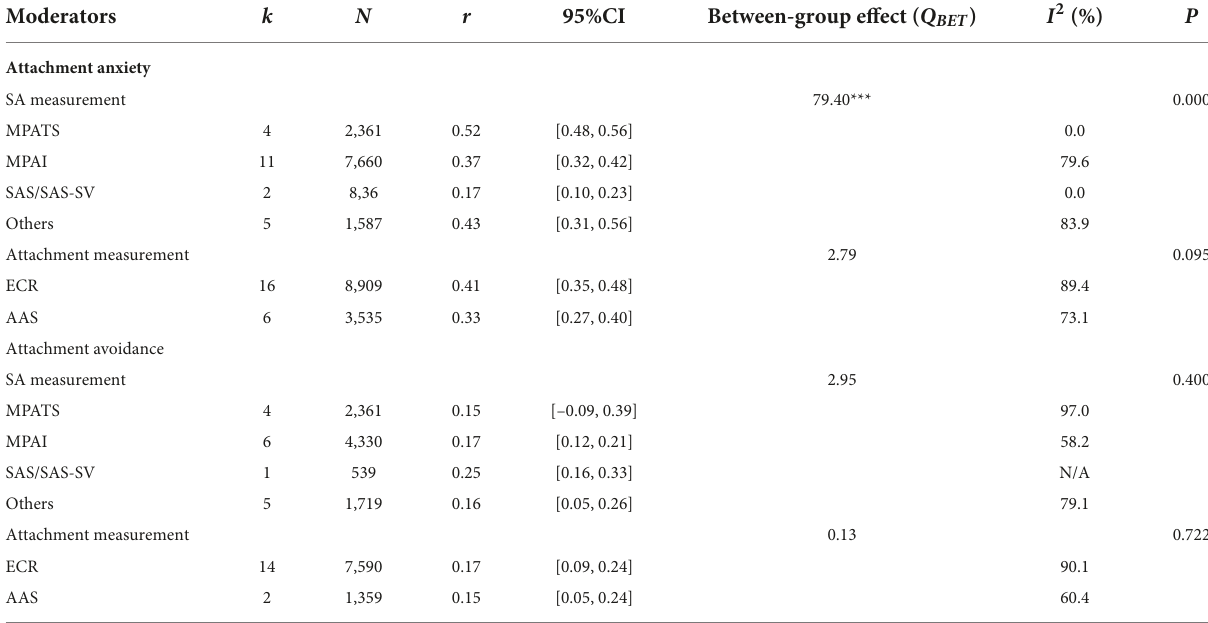
TABLE 5 Subgroup analyses of the summary correlation between SA and